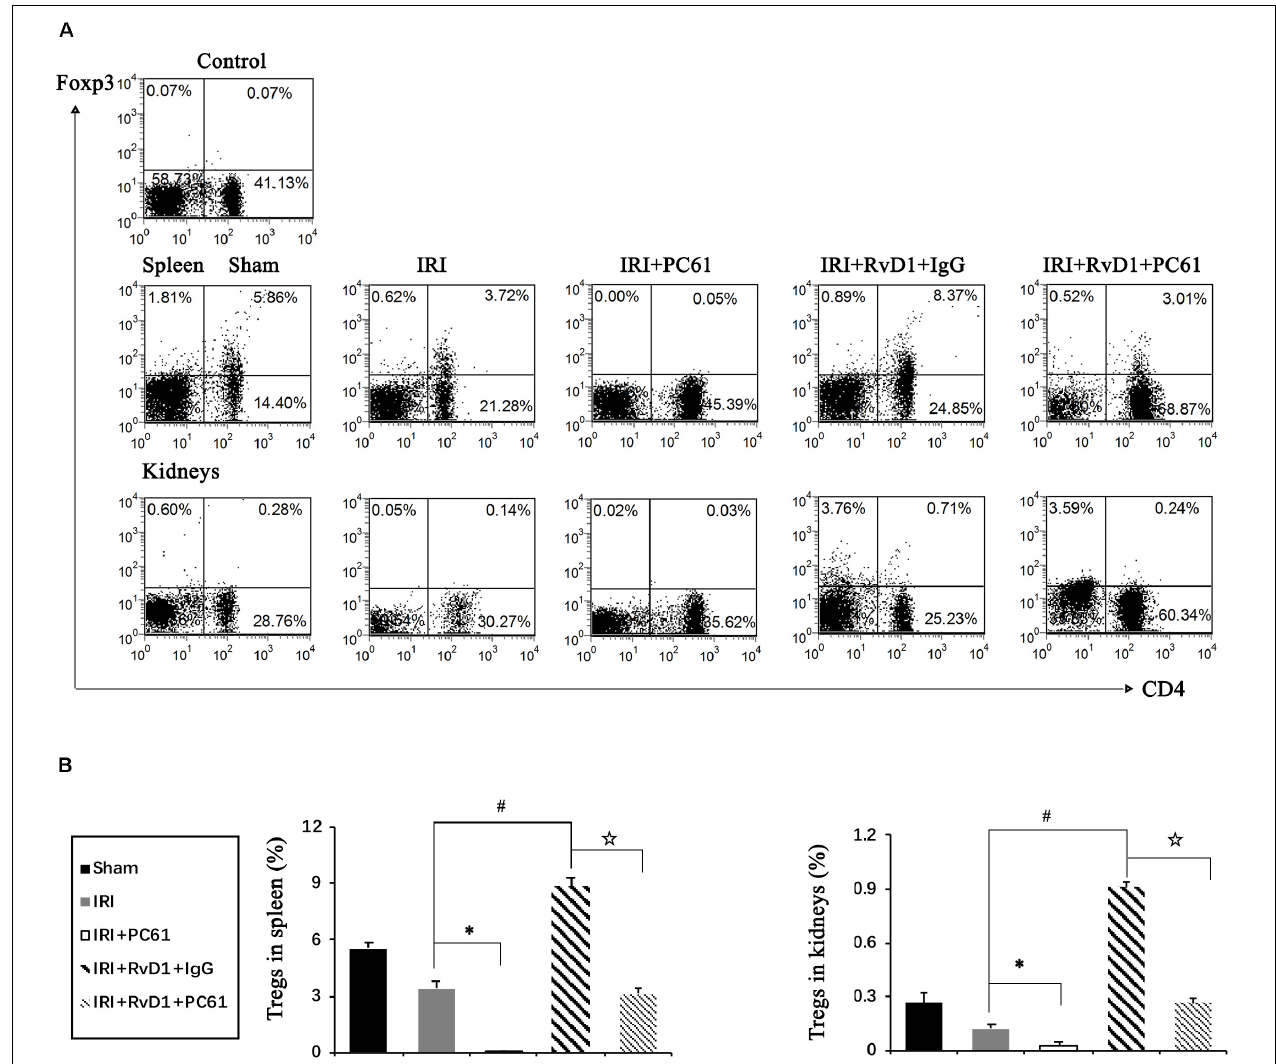
FIGURE 3 | PC61 administration reduced Treg percentages in the spleen and kidneys of IRI-AKI mice. The IRI-AKI model was established, and PC61 or rat IgG was administered via the tail vein after RvD1 or vehicle interventions. Single-cell suspensions were generated from the spleen and kidneys at 72 h after reperfusion. (A) Representative flow cytometry analysis of CD4 + Foxp3 + T cells obtained from the spleen or kidneys of IRI-AKI mice treated with or without RvD1, PC61 or rat IgG. The plots are gated for CD4 + lymphocytes. The data are representative of 3 independent experiments. (B) The percentage of CD4 + Foxp3 + T cells in the spleen or kidneys. Values are expressed as the means ± SDs, n = 6–8 per group. ∗ P < 0.05, IRI + PC61 versus IRI; # P < 0.05, IRI + RvD1 + IgG versus IRI; IRI + RvD1 + IgG versus IRI + RvD1 +